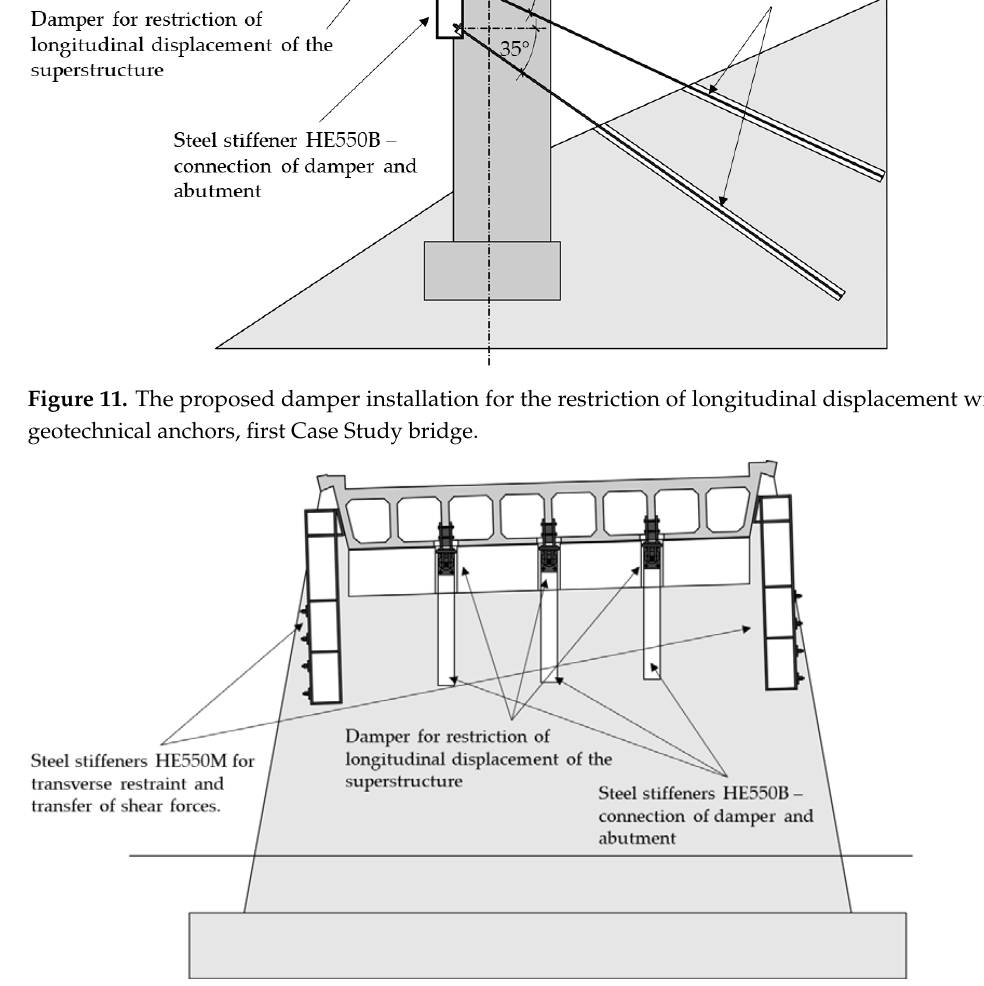
Figure 13. ( a ) Masonry abutment and ( b ) composite superstructure of the bridge to Majske Poljane.